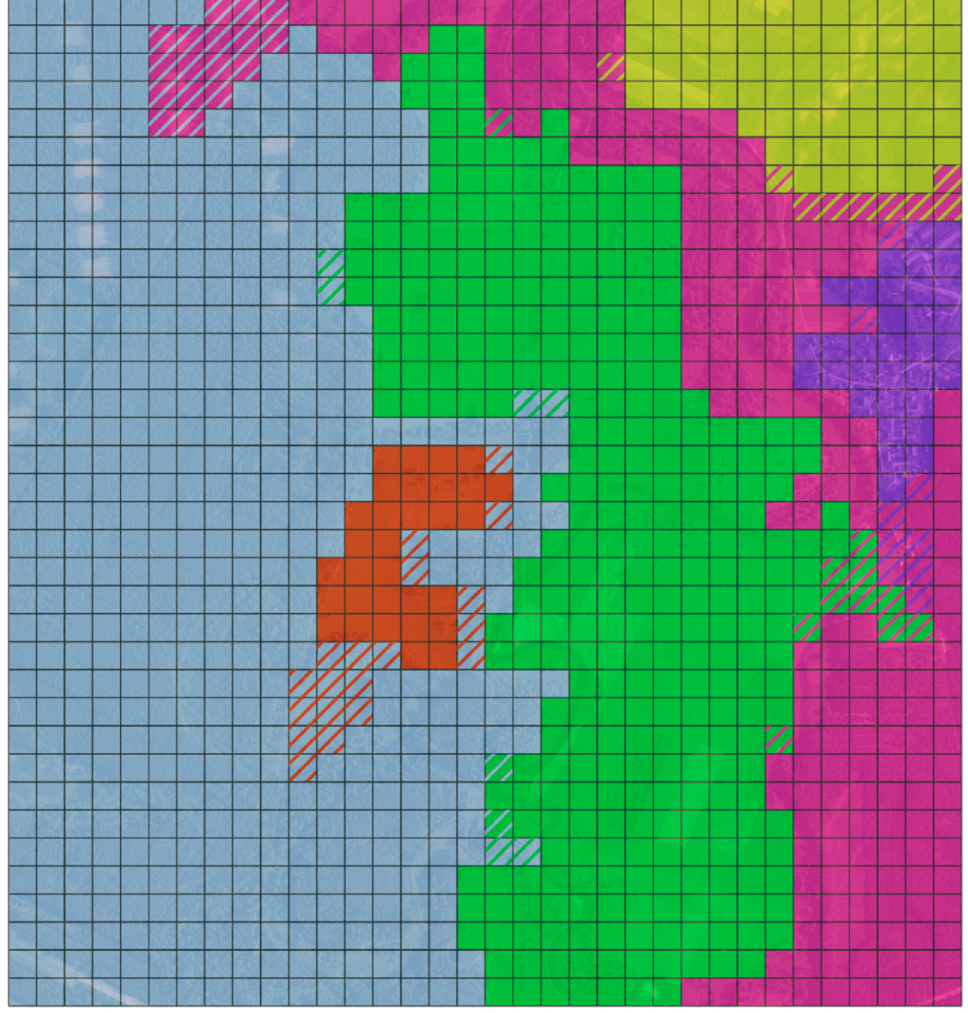
Figure 9. Clustering results of sample orthophoto (72961_840430_M-34-40-B-a-2-3 [42]) patches for fixed number of clusters ( n clusters = 6). Each color represents a different cluster. Filled squares are the result of latent space clustering. The line pattern indicates the difference between the latent space clustering results and ground truth prepared by manual annotation.